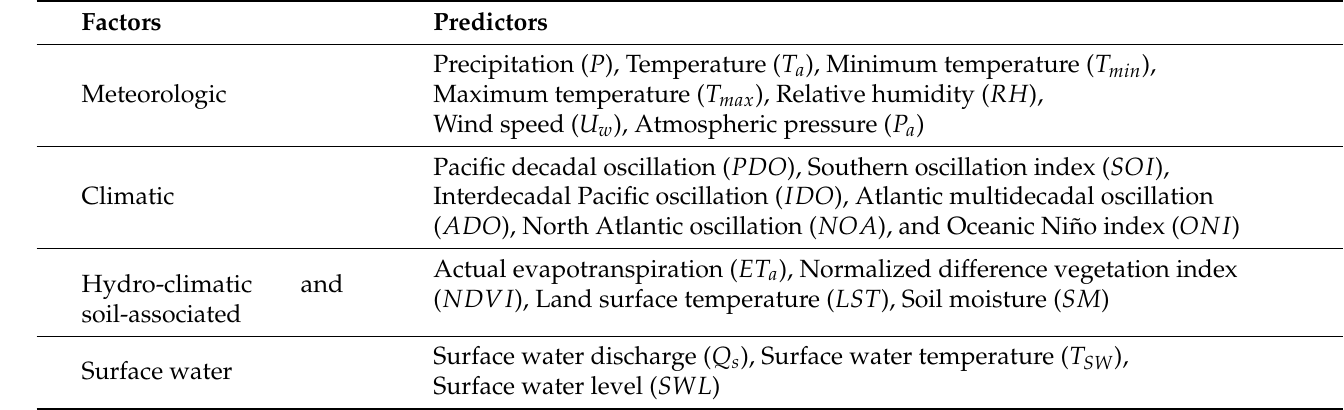
Table 8. Factors and predictors used in IAI-based drought